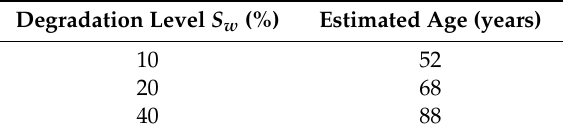
Table 3. Estimated age of natural stone claddings for three di ff erent S w values (single-parameter deterministic